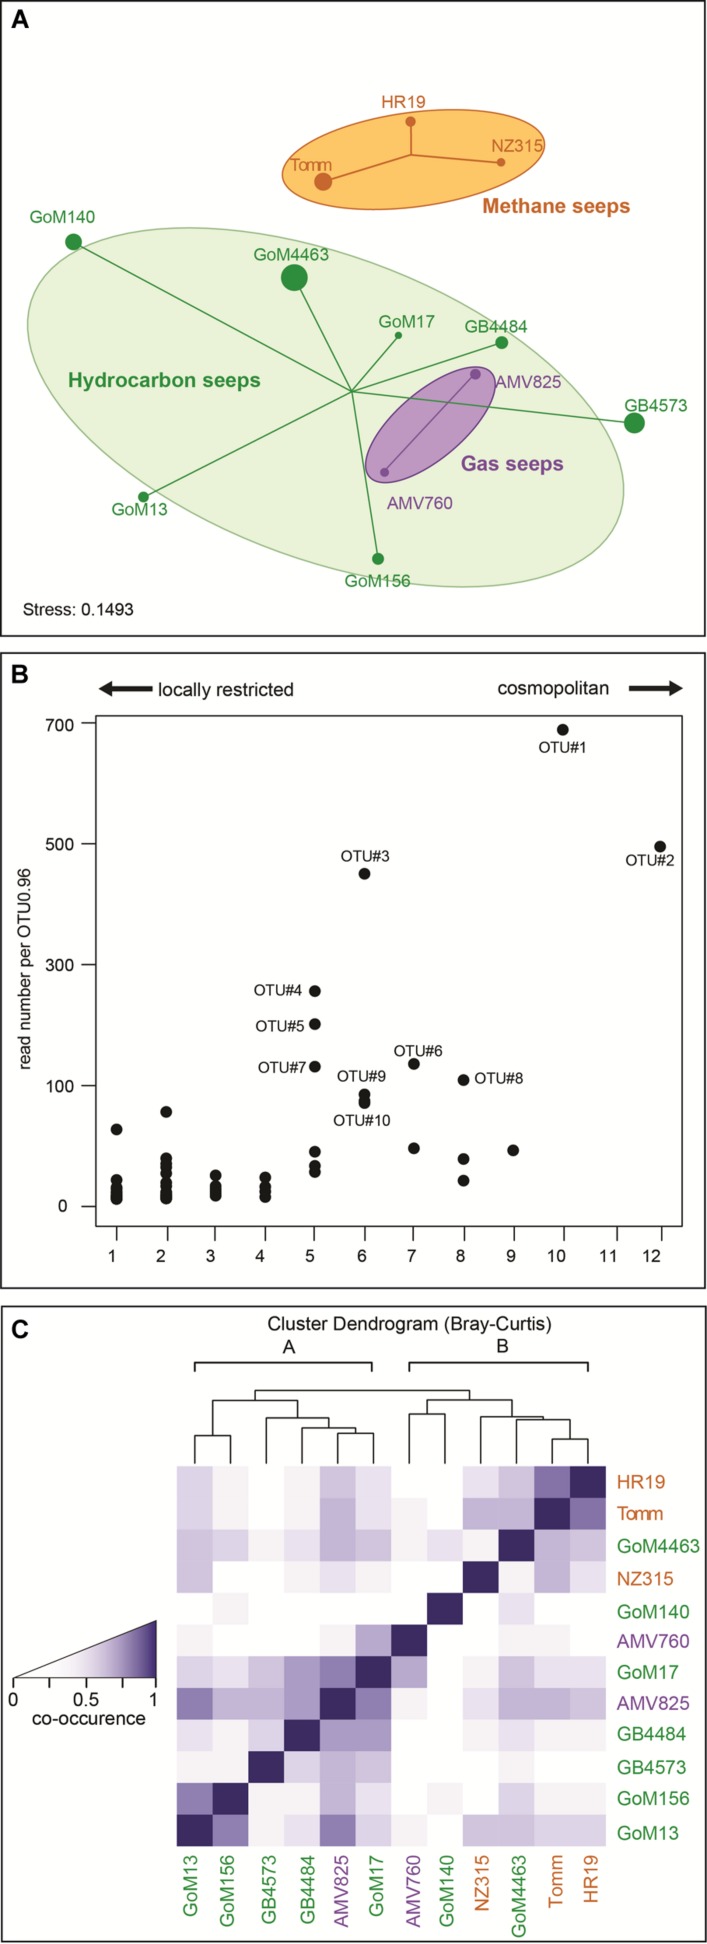
Similarity of MasD community structure in investigated seep sediments.
(A) Similarity of MasD community structure visualized by non-metric multidimensional scaling. Ordination based on species level OTU0.96 dissimilarities (Bray–Curtis). Each sample (dot) is connected to the weighted averaged mean of the within group distances. Ellipses represent one standard deviation of the weighted averaged mean. Dot size reflects Inverse Simpson index (1/D), hence the larger a dot the higher the diversity. The mean percentage of shared MasD OTU0.96 between any two sites was 9%, lowest was 0% and highest was 43%. (B) Abundance and occurrence of MasD OTU0.96. Given abundance is based on number of reads per OTU0.96. OTU0.96 that were present in only 1 of the 12 investigated sediments were defined as locally restricted while those OTU0.96 that were present in at least 10 of the 12 sites were defined as cosmopolitan OTU0.96. (C) Co-occurrence of OTU0.96 among the investigated seep sites. The darker the color the more frequent the co-occurrence.